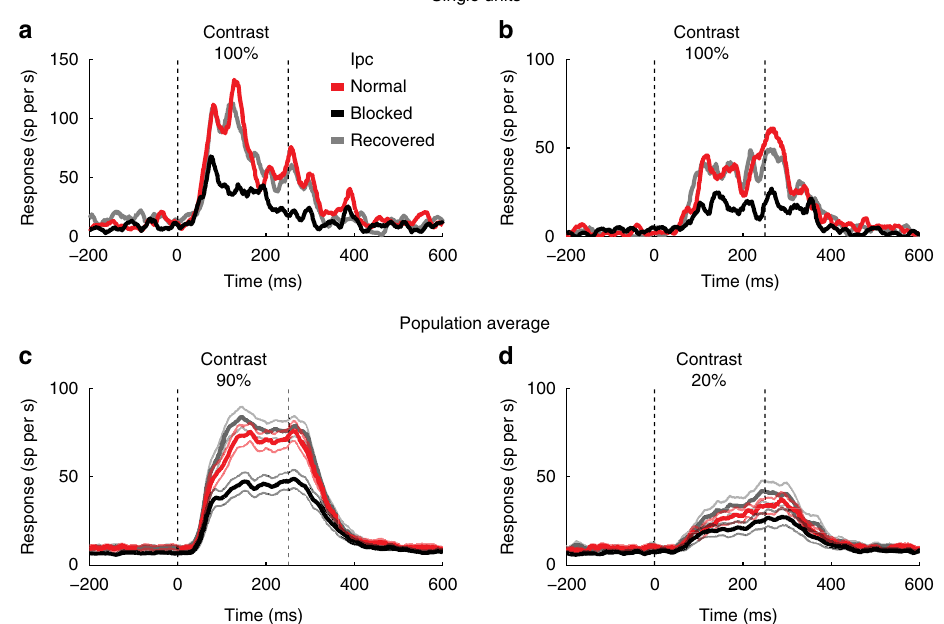
Figure 8 | Effect of Ipc blockade on OT response time course. The data compare the time courses of OT unit responses to looming-dot stimuli (8 (cid:2) per s) presented at the centre of the VRF measured before, during and after Ipc blockade. Vertical dashed lines: duration of the stimulus. ( a , b ) Time courses of single OT units to full contrast stimuli. ( c , d ) Population average ( n ¼ 41) time courses of responses to 90% contrast ( c ) and 20% contrast ( d ) looming dots. Shaded lines: